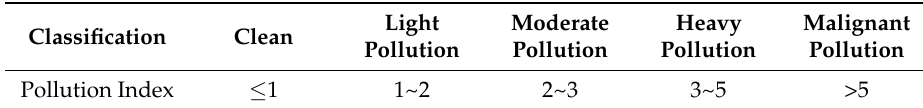
Table 3. The Classification of Nemerow